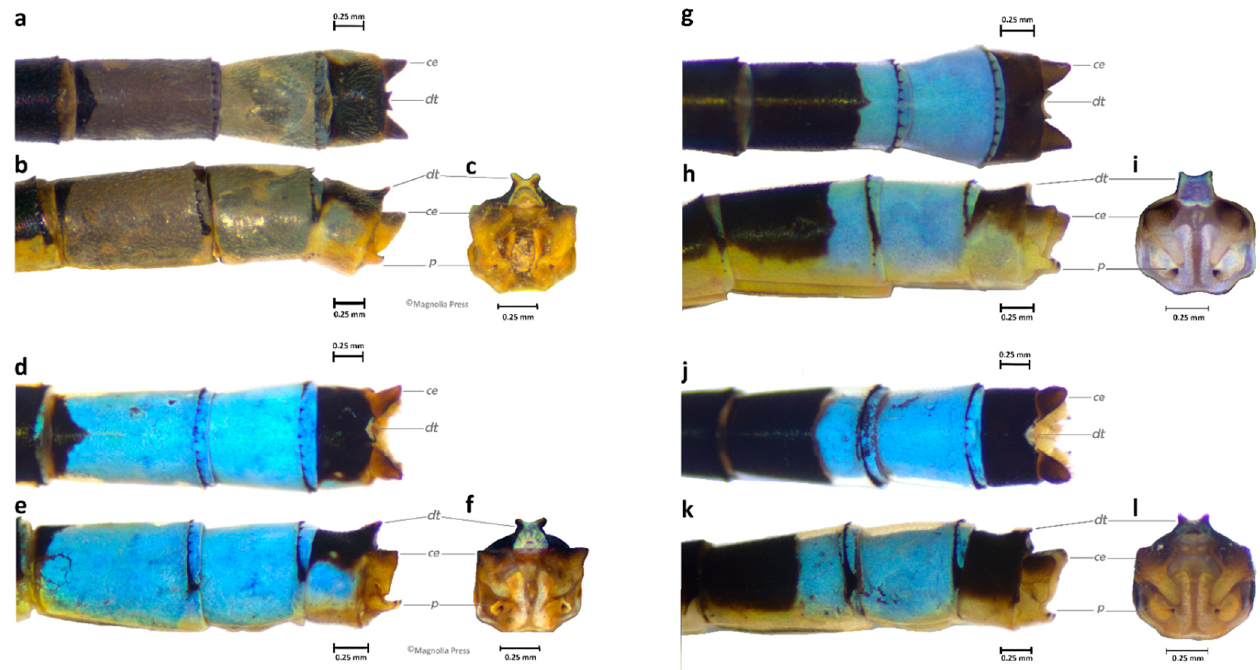
Figure 8. Dorsal, lateral, and posterior view of the abdominal appendages of I. rubilio ( a – c ) and I. aurora from China ( d – f ), Australia ( g – i ), and Fiji ( j – l ). dt : dorsal tubercle; ce : cerci; p : paraprocts. Images ( a – f ) are partly reproduced from Sanmartín-Villar et al . [14] with permission from the copyright holder.